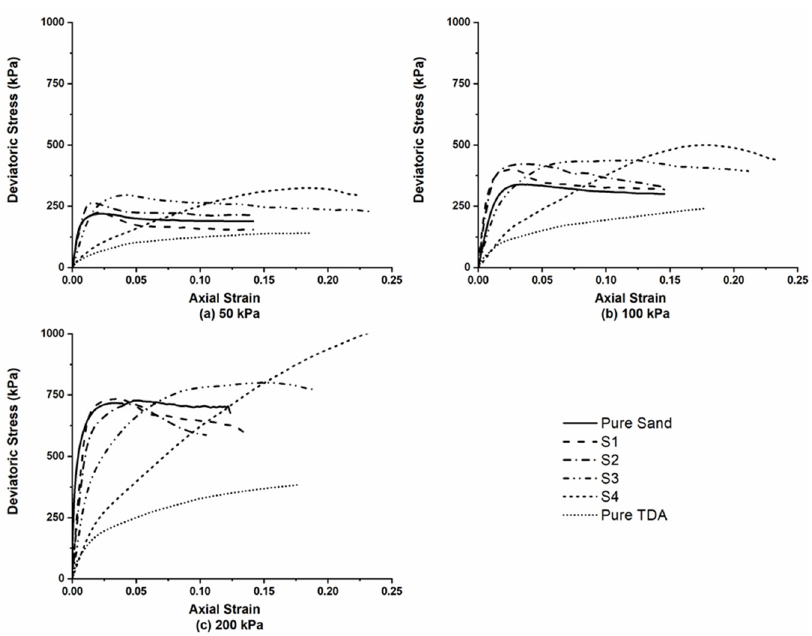
Figure 8. Deviatoric stress versus axial strain for TDA ‐ sand samples with 0%, 5%, 10%, 30%, 50%, and 100% TDA by weight at confining pressures of 50 kPa, 100 kPa, and 200 kPa.